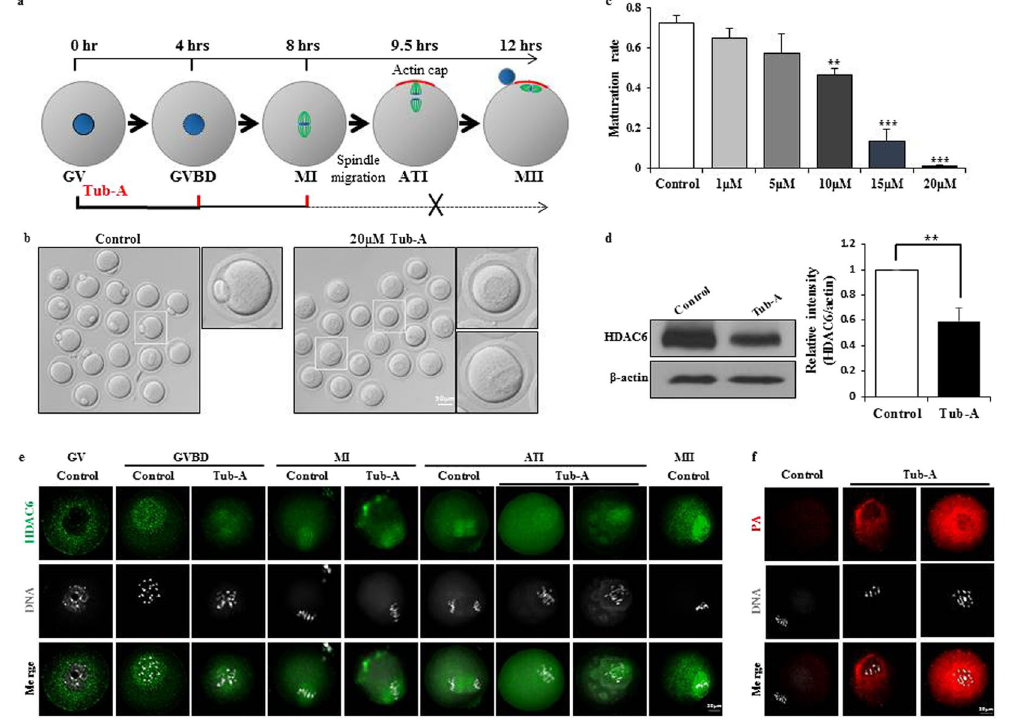
Figure 1. Effect of Tub-A on oocyte maturation. ( a ) Tubastatin A treatment time course during oocyte maturation. Blue circle, nuclear; green line, spindle; red line, actin cap. ( b ) Images of MII stage oocytes in the control and Tub-A treatment group. ( c ) Quantitative analysis of the first polar body extrusion rate after 12 h of in vitro culture. Graph shows means ± SD of results obtained in three independent experiments. ( d ) Western blot showing partial knockdown of HDAC6 after treatment with 20 μ M Tub-A. ( e ) Confocal imaging analysis of HDAC6 localisation during oocyte meiosis. Oocytes at GV, GVBD, MI, ATI, MII stages are immunolabelled with HDAC6 antibody (green) and counterstained with TO-PRO-3 to visualise DNA (gray). ( f ) Confocal images of aggresome formation levels in oocytes matured in the presence of Tub-A. Red, protein aggregates; Grey, nuclear. The rate is significantly different ( ** p < 0.01; *** p <